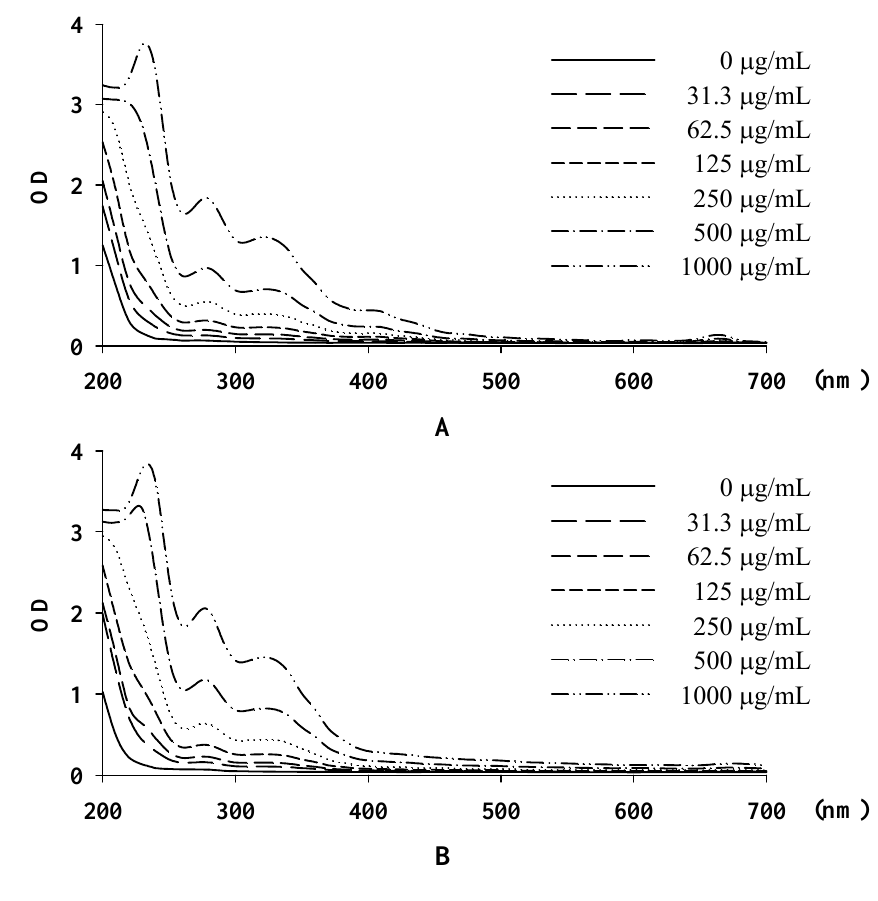
Figure 1. Absorption spectra of IPE in different solvent. ( A ) MeOH; ( B ) 50% PG and ( C )